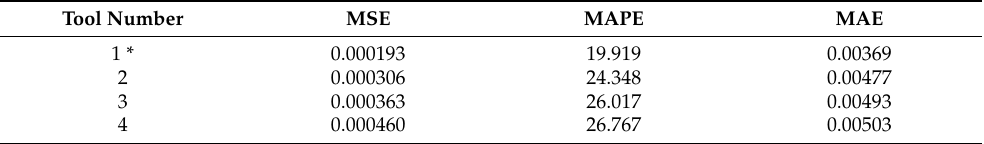
Table 6. Results of inferencing with the Best Model (Use the Tool number 1 data as a training model). Tool Number Tool Number